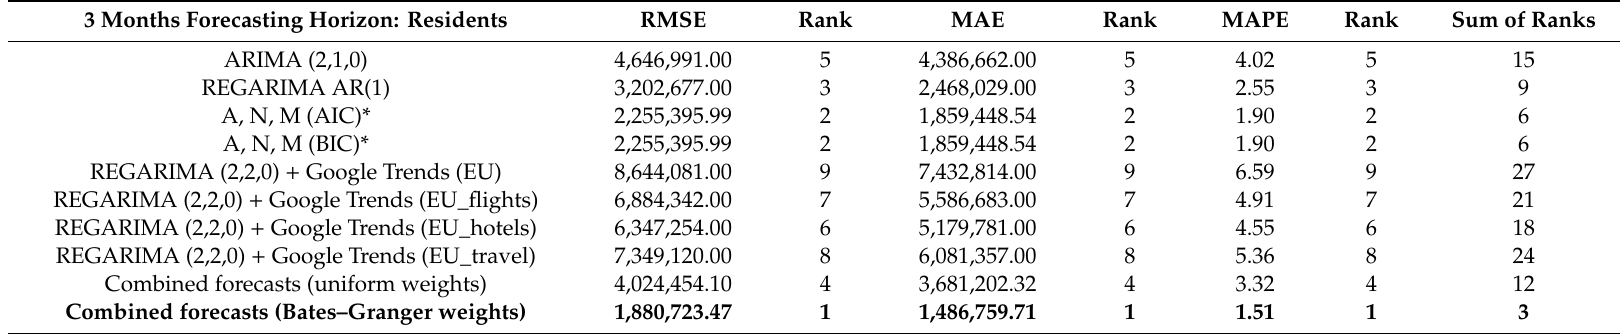
Table A7. Forecasting accuracy (December 2017): overnights, residents, three months ahead. Source: European Commission (2017) and own calculations. * AIC and BIC selected the same model. Boldface indicates the single forecasting model(s) / forecast combination technique(s) characterized by the lowest sum of ranks. 3 Months Forecasting Horizon: Residents